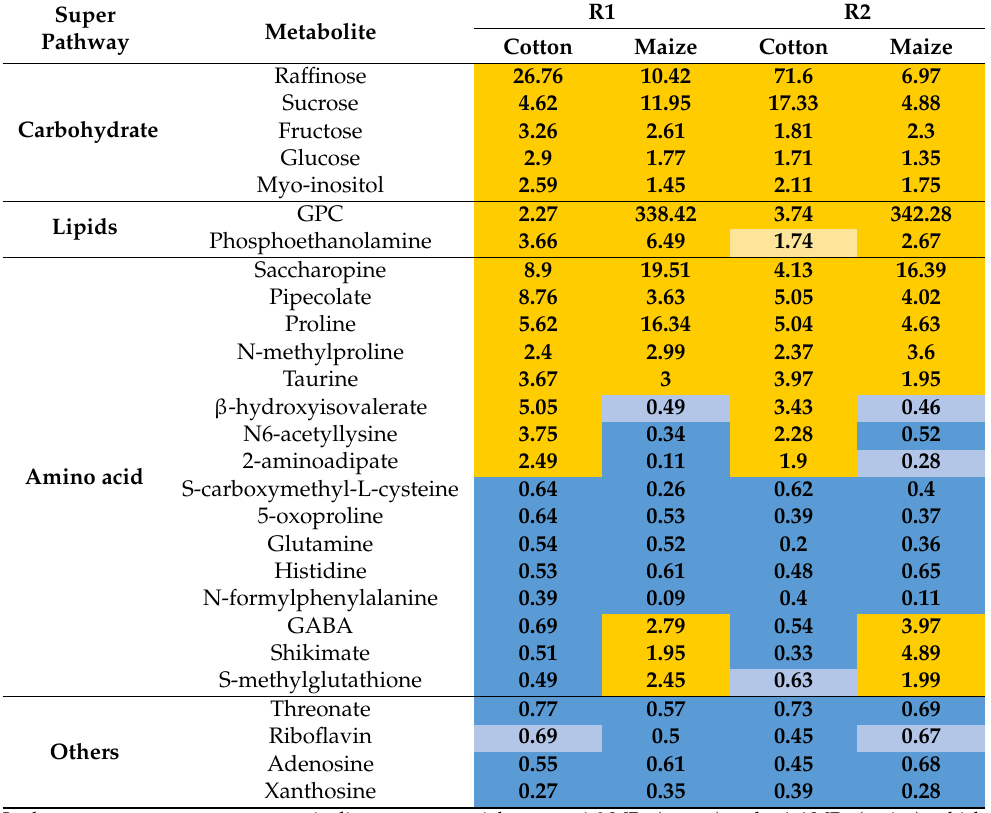
Table 1. Ratios of metabolite abundance between water-stressed and well-watered primary roots of cotton and maize for metabolites showing consistent responses in R1 and R2 of the elongation zone. R1 R2 Super Metabolite Pathway Cotton Maize Cotton Maize